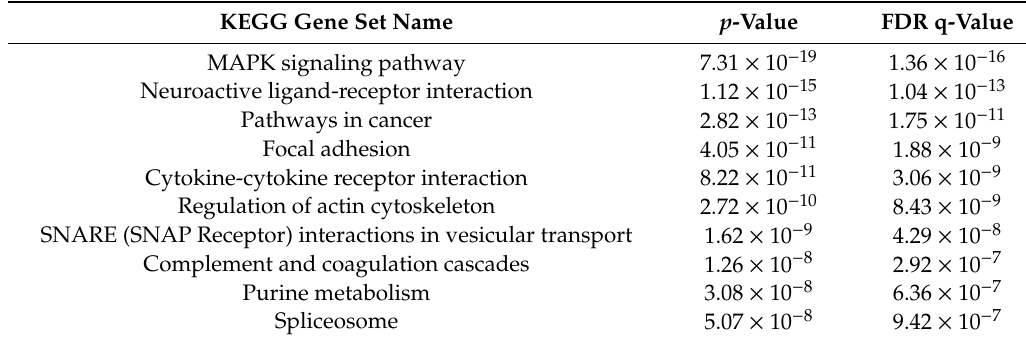
Table 1. Functional annotation of the driver gene